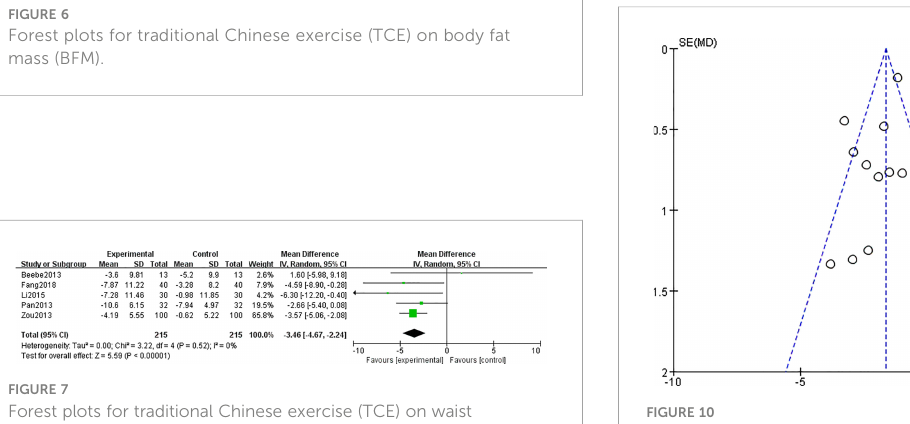
FIGURE 10 Funnel plots of the body mass index (BMI).